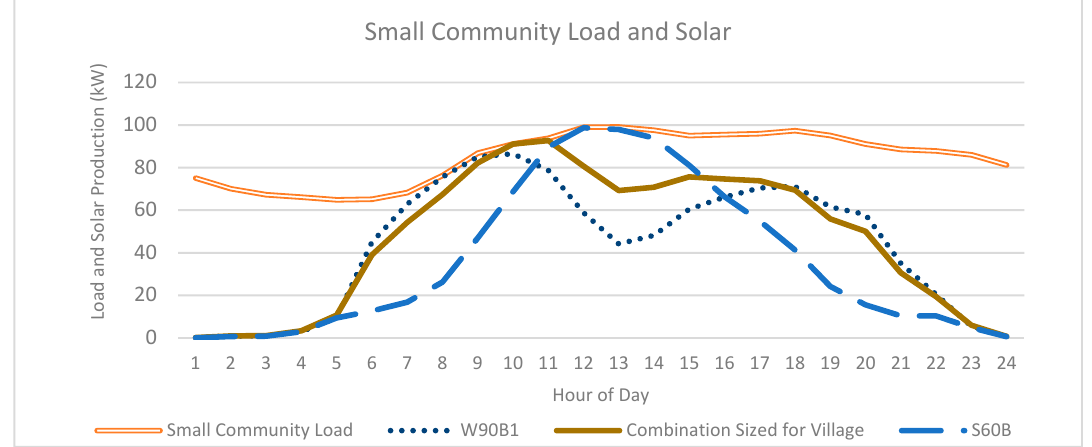
Figure 12. A load profile for a Rural Alaska community is scaled to 100 kW max load and shown along with June production profiles scaled to never exceed the load for south-facing bifacial, east-west vertical bifacial, and a combination of these orientations.